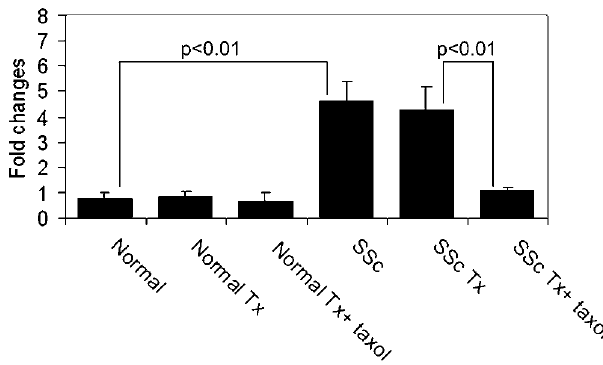
Figure 2. Paclitaxel Decreases COLA2 mRNA Expression in SSc Grafts TRT-PCR analysis shows that the expression of COL1A2 is reduced 4.5-fold with paclitaxel (Taxol) treatment in SSC grafts, reaching a level equivalent to that of normal skin grafts. By contrast, paclitaxel has no effects on COL1A2 expression in normal skin grafts.